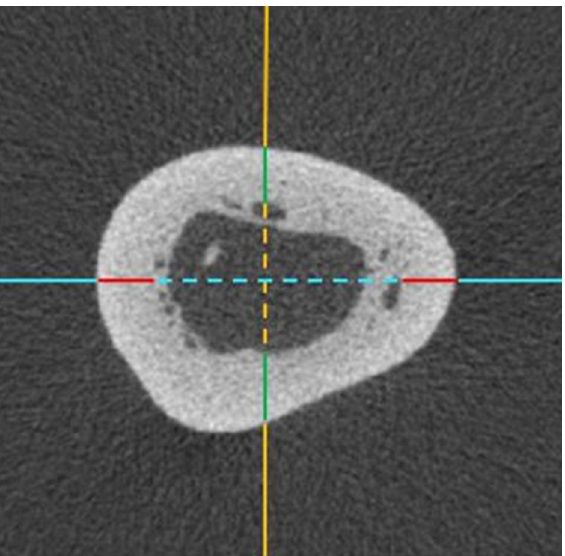
Figure 3. Transverse micro-CT slice taken from the distal third measurement site. Top of the image is cranial, left of the image is lateral. Solid orange = craniocaudal plane; solid blue = mediolateral plane; solid green = cranial and caudal cortical thicknesses; solid red = medial and lateral cortical thicknesses; dotted orange = internal diameter of craniocaudal plane; dotted blue = internal diameter of mediolateral